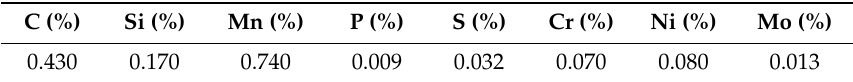
Table 1. Chemical composition of the C45 material.